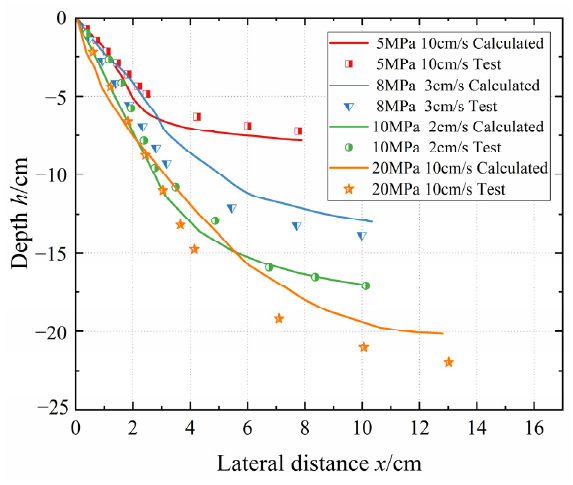
Figure 15. Comparative verification of prediction formulas.